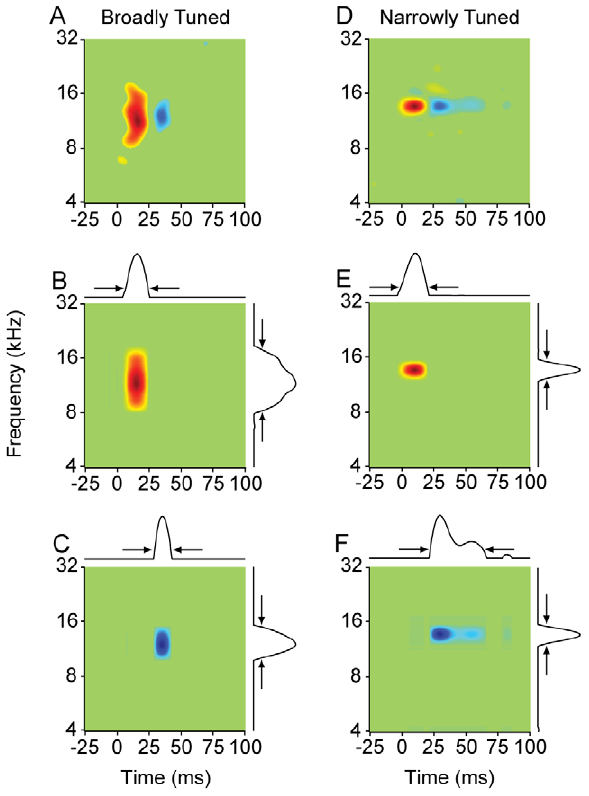
Figure 3. Method for determining the temporal and spectral extent of excitatory and inhibitory STRF subfields. Each column represents one neuron (A–C: broadly tuned; D–F: narrowly tuned). Singular value decomposition (SVD) was performed on either the excitatory (B,E) or inhibitory subfield (C,F). Time and frequency 1D marginals are shown above, and to the right, of each separable component in B, C, E, F. The first separable component from the SVD analysis was used to extract the subfield width at 10% of the peak value (arrows).